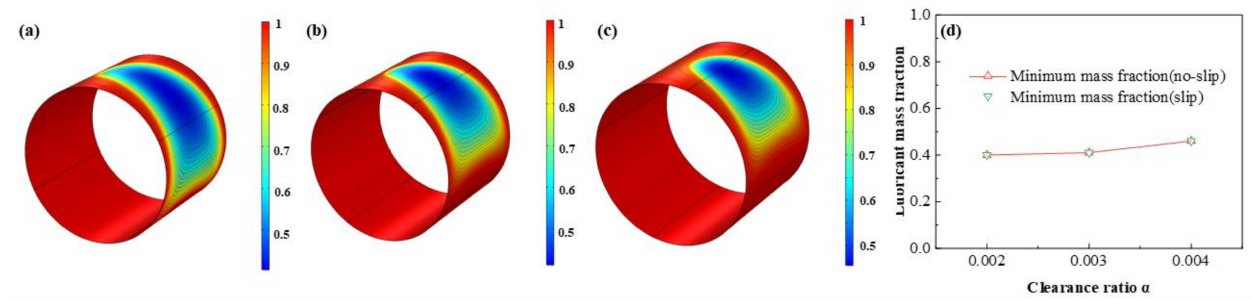
Figure 24. Comparison of the liquid mass fraction distribution under different clearance ratios. ( a ) α = 0.002; ( b ) α = 0.003; ( c ) α = 0.004; ( d ) minimum liquid mass fraction.